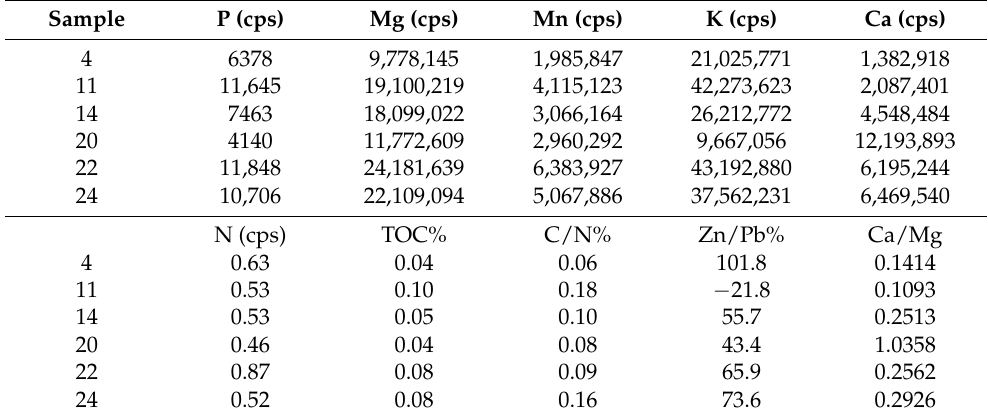
Table 4. The content of each metal of sediment samples in the Lu’erhuan River Sea area of Qinzhou Bay, Guangxi